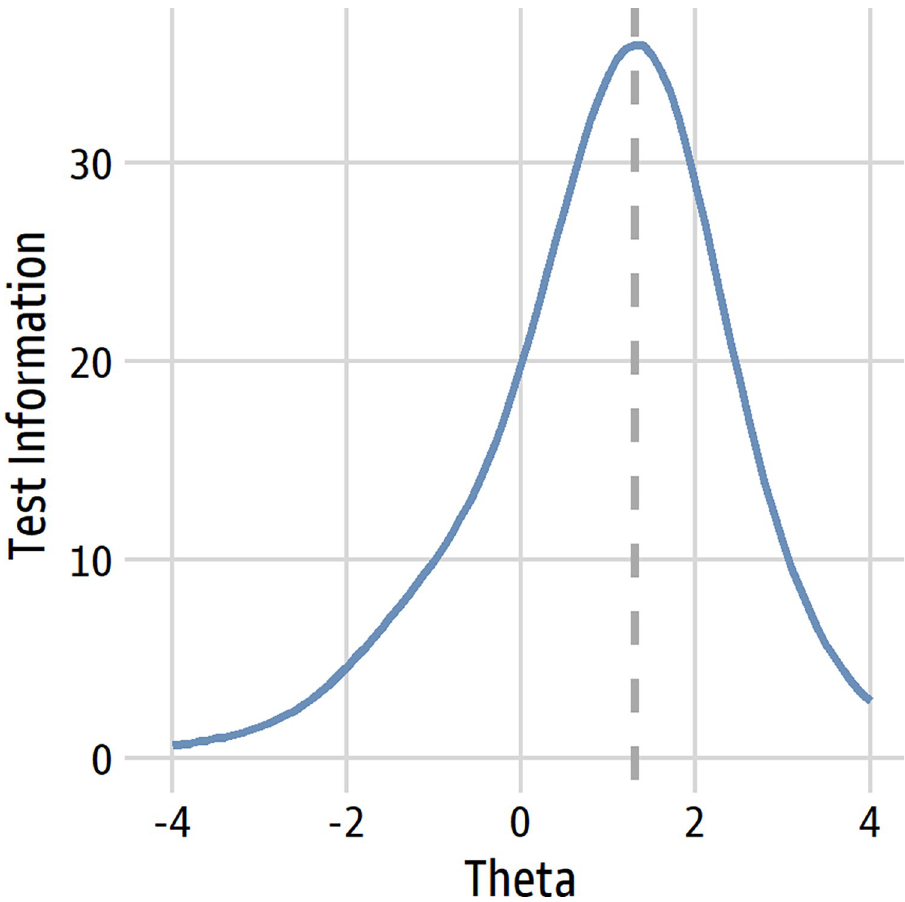
Fig 4. Test information function. The dashed line denotes the peak at